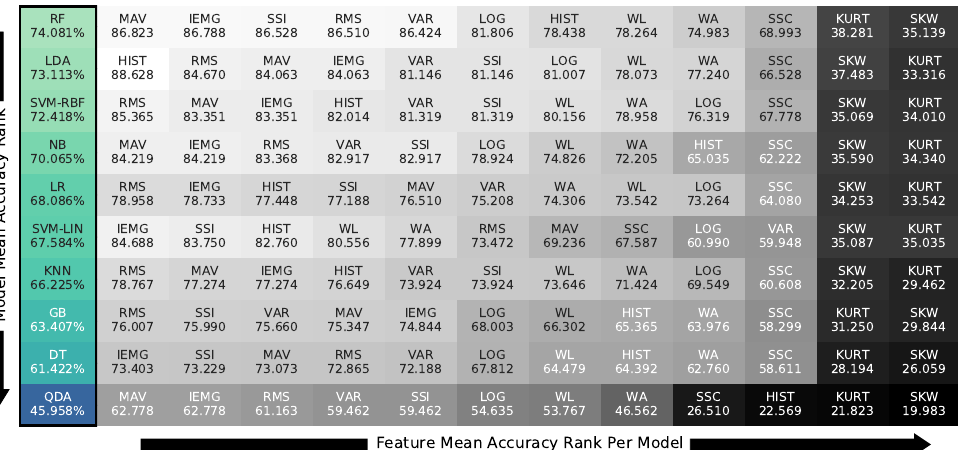
Figure 10. Classifier accuracy ranking on the 1250 ms window with the features’ sub-ranking using all participants’ grasp